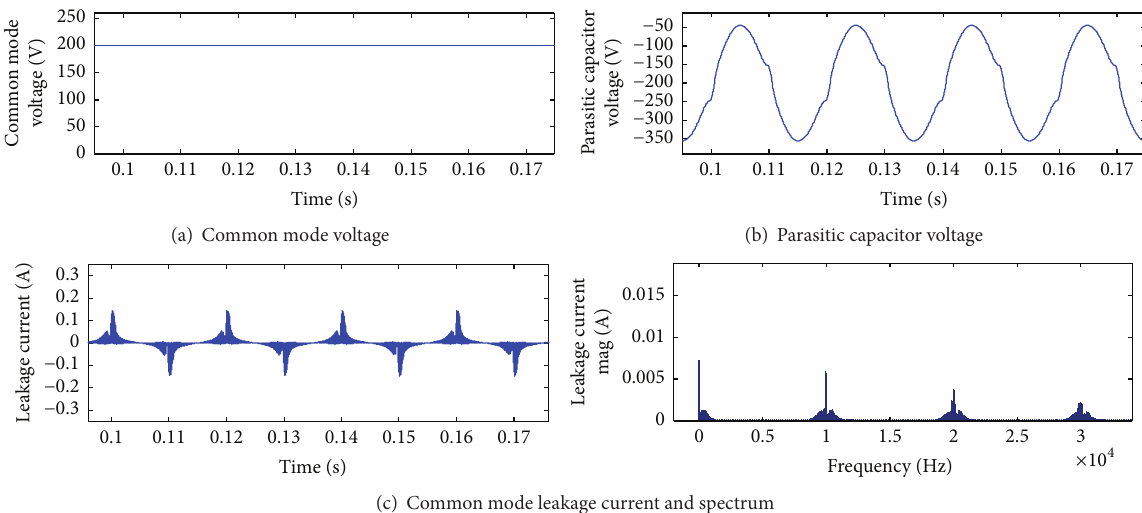
Figure 7: Simulation results of common mode voltage and leakage current.